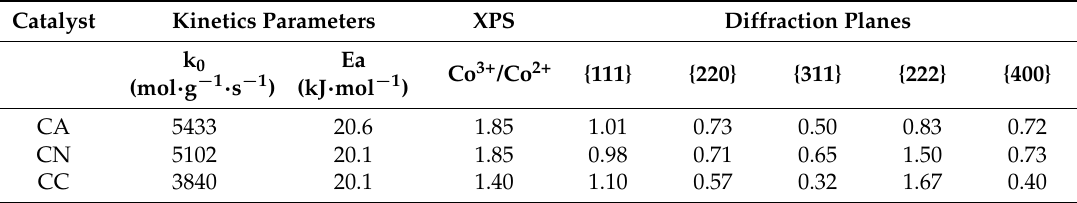
Table 1. Reaction kinetics parameters, Co 3+ /Co 2+ ratio calculated from deconvoluted X-ray photoelectron spectroscopy (XPS) spectra and XRD relative intensity of primary crystal planes of Co 3 O 4 [16] a . Catalyst